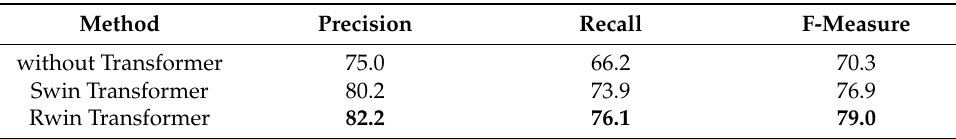
Table 5. Performance comparison of network